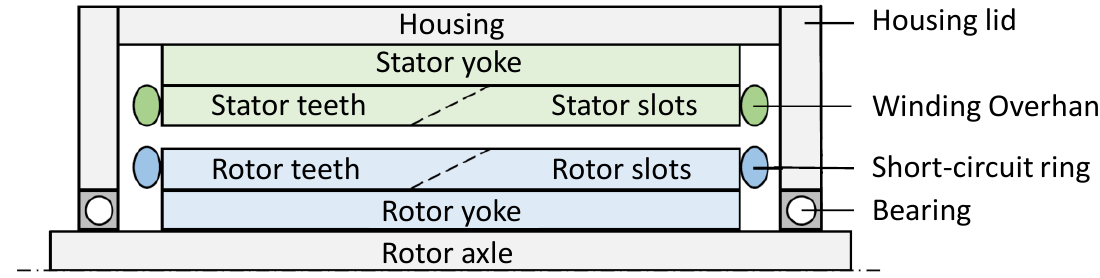
9 of 16 Figure 6. Machine winding overhang temperature for the NEmo. 4. Thermal and Vehicle Model 4.1. Thermal Model The construction and validation of the simulation model, consisting of the vehicle and thermal machine model, is implemented using the MATLAB® extension Simulink® , a block diagram environment for model-based development, modeling and simulation [17]. For the thermal simulation of the electric machine, the approach of the "Light Gray Box" LPTN is selected in this article. The reason for this is the partly incomplete geometry information about the exact structure of the electric machine, e.g., in the area of the winding head or housing, which makes